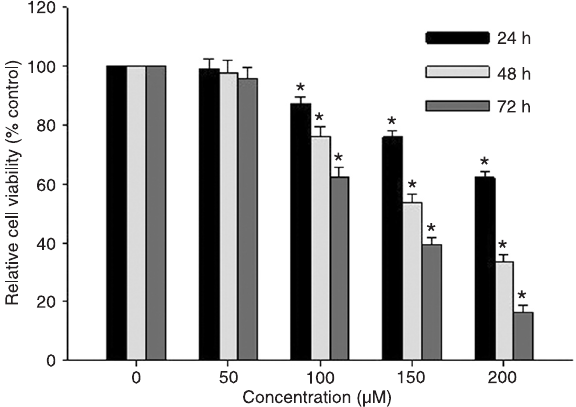
Figure 1. Rhein-induced anti-proliferation of SGC-7901 cells. SGC-7901 cells were treated with rhein at doses of 0, 50, 100, 150, or 200 µM for 24, 48, and 72 h. Cell viability was evaluated with the MTT assay and results are reported as relative cell viabil- ity (%). All data were normalized to the control group, which was considered to be 100%. The results showed that rhein inhibited proliferation of SGC-7901 cells in a dose- and time-dependent manner. *P < 0.05 versus control group (0 µM) (two-way ANOVA followed by the Tukey post hoc test).